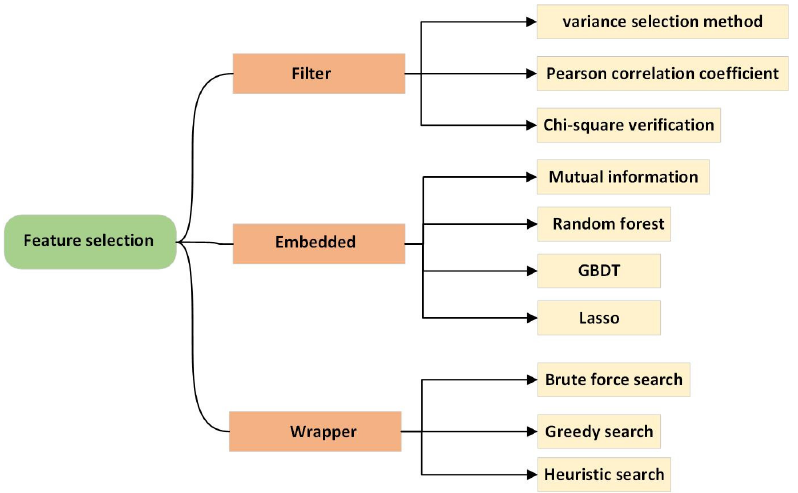
Figure 3. Classification of feature selection